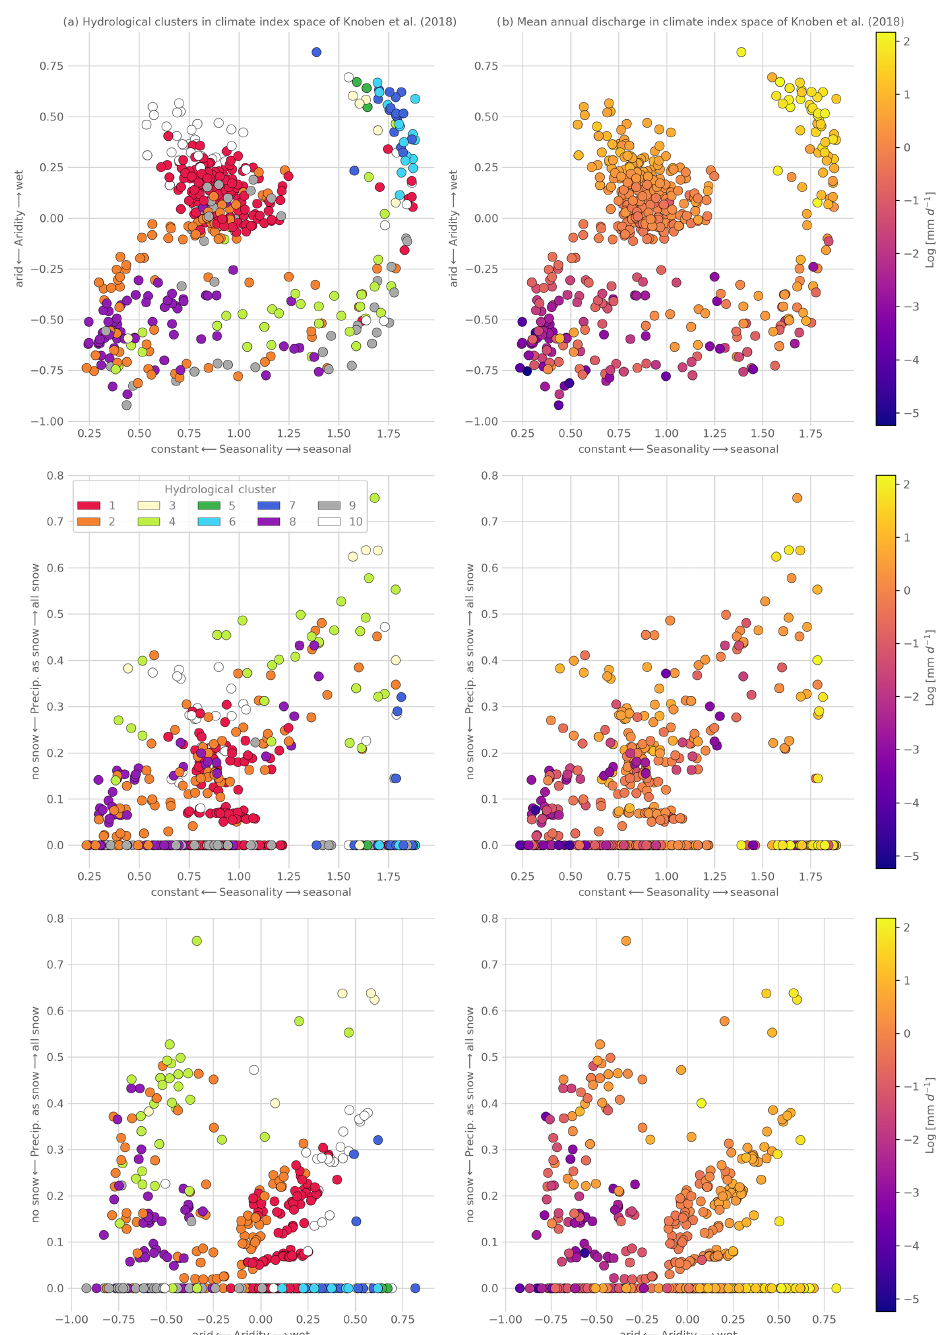
Figure 11. (a) Comparison of the hydrological clustering of this study with the climate index space of Knoben et al. (2018). Single dots show the catchments and are colored by their hydrological clusters. (b) Mean annual discharge for all catchments in the climate index space of Knoben et al. (2018). Single dots show the catchments and are colored according to the value of the mean annual discharge. The log of the mean annual discharge is used to show the relative differences between the catchments. For a depiction of all hydrological signatures used, see Fig.